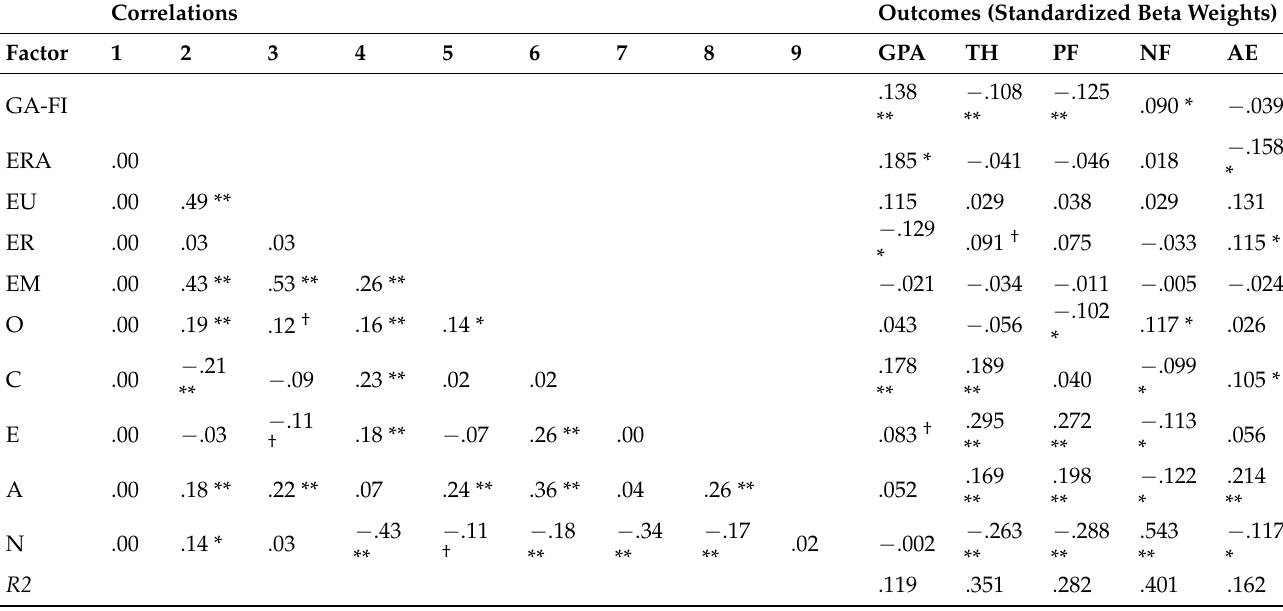
Table 5. Multivariate Latent Regression analyses of the Bifactor (S-1) Model (Reference Facet = Fluid Intelligence) with GECo Branches and Big Five as Covaried Predictors and GPA, Well-Being Factors, and Affective Engagement as Covaried